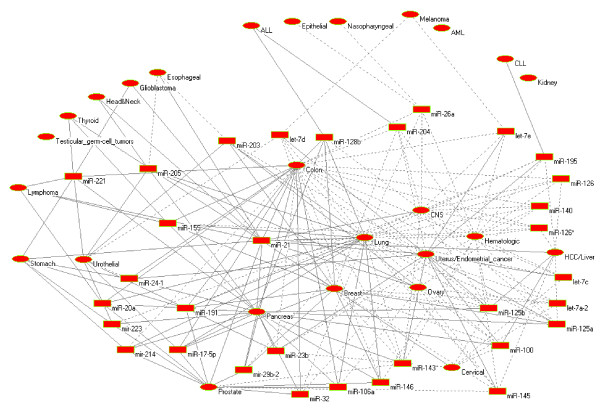
Hubs of the network. Solid edge = overexpression/amplification, dotted edge = underexpression/deletion.